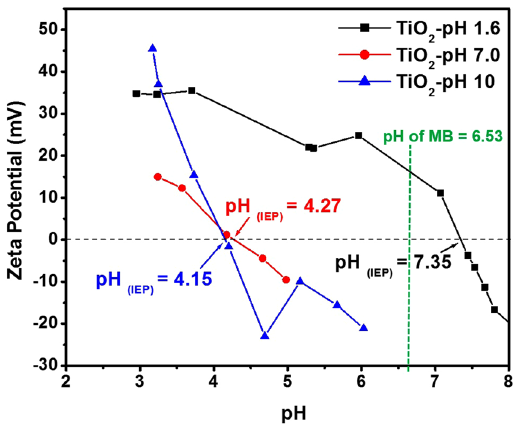
Figure 7. Zeta potential measurements of TiO 2 NPs prepared at different pH values; 1.6, 7.0, and